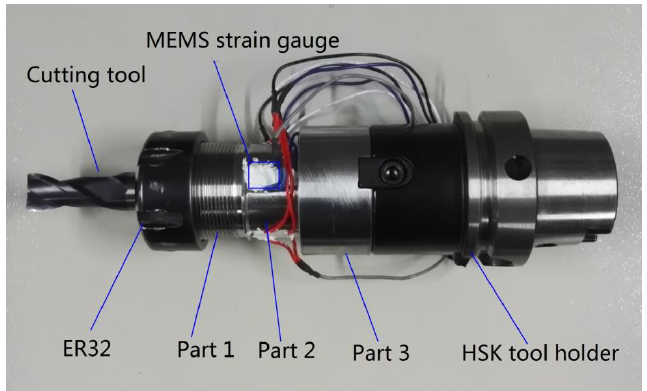
Figure 4. Photograph of the fabricated torque sensor.